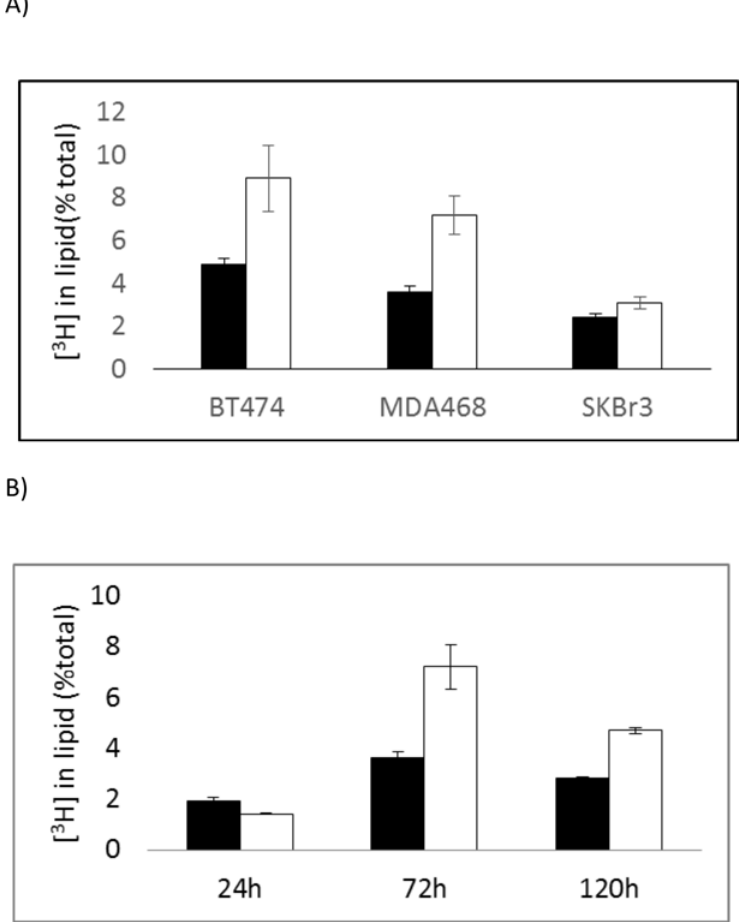
Fig 2. Proportion of [3H-methyl]choline accumulated in the lipid fraction by untreated (black) and metformin-treated (white) breast cancer cells during a 15minute incubation with [ 3 H-methyl]choline followed by a 1h chase (medium replaced with non-radioactive medium) expressed as a percentage of total cell [ 3 H-methyl]choline uptake. (A) BT474, MDA-MB-468 and SKBr3 cells treated with Metformin for 72 h and (B) MDA-MB-468 cells treated with metformin for 24, 72 and